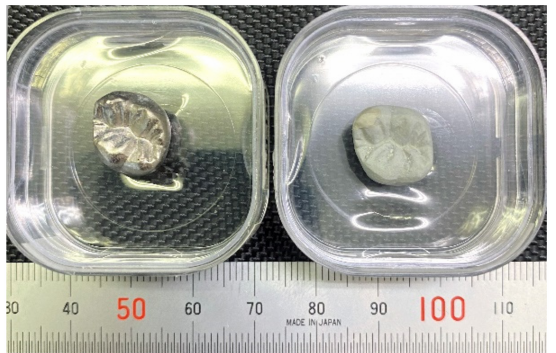
Figure 1. Prototype of titanium dental crown with/without oxidation. ( Left ) Ti crown without oxidation; ( Right ) with oxidation at 1273 K for 1.8